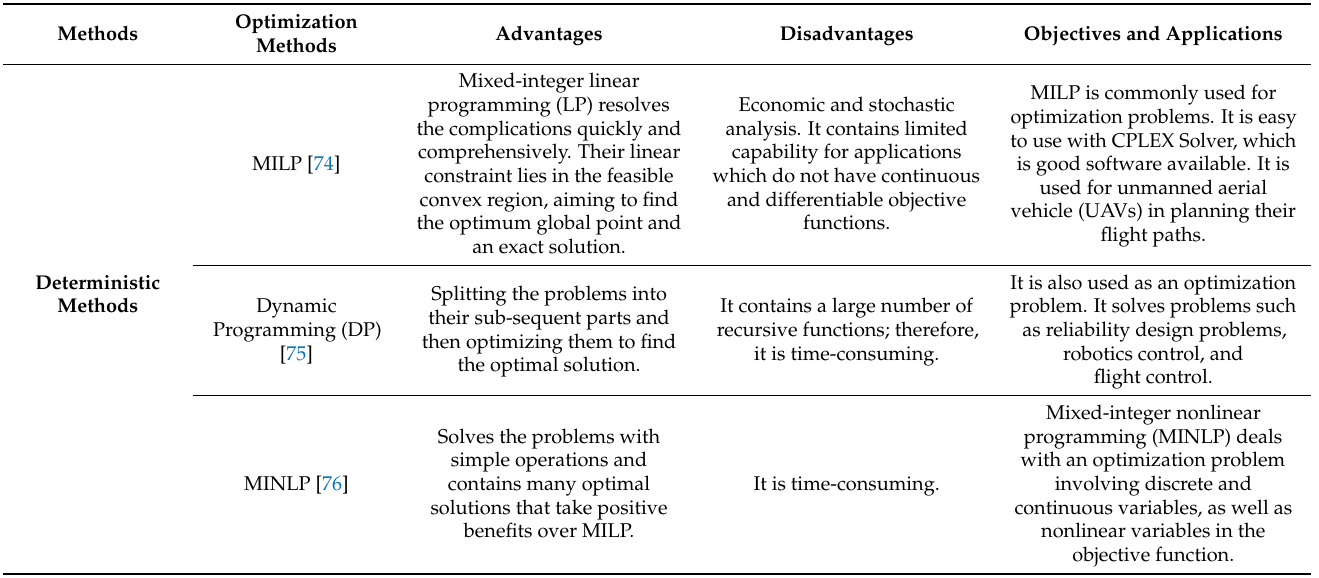
Table 3. Comparison of optimization methods considering advantages and disadvantages.